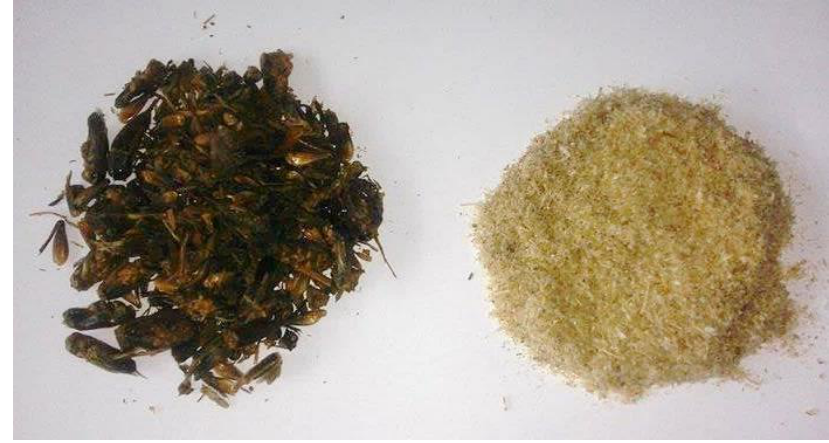
Figure 10. Images of crickets ( left ) and final product after multistep processing ( right ).